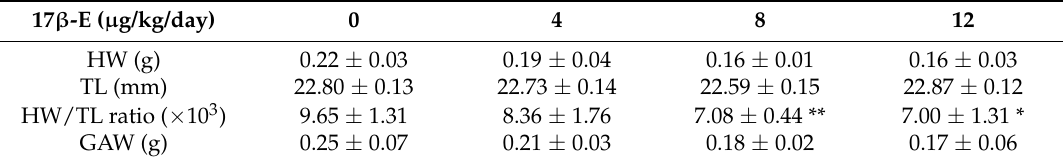
Table 1. The physiological characters of high-fat diet-fed male C57B mice with different 17 β -E treatments. HW = heart weight, TL = tibia length, GAW = Gonadal adipose weight (* = p < 0.05; ** = p <